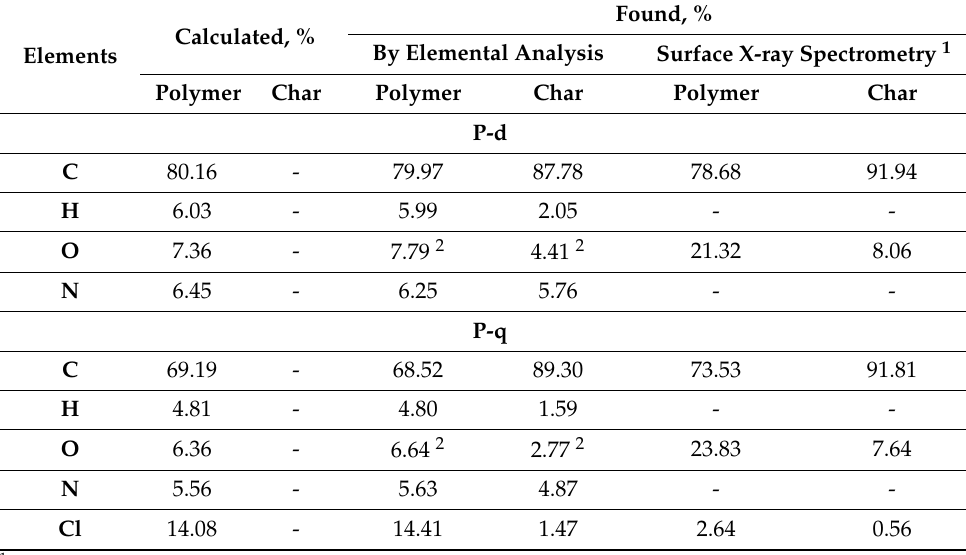
Table 5. Elemental analysis data for polybenzoxazines and char residue.